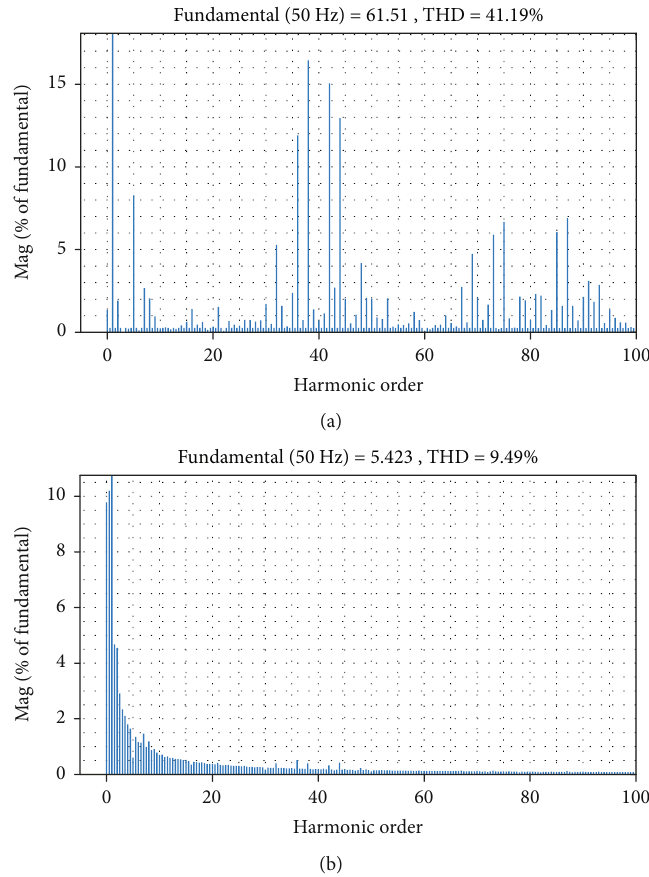
V V an , bn , and cn ) and (b) currents (